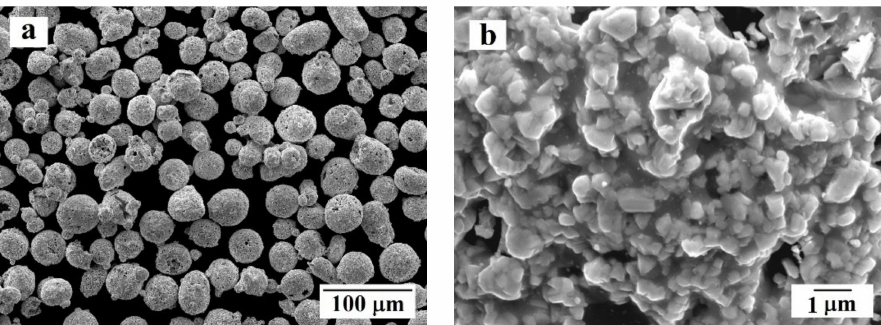
Figure 2. WC-Co-Cr powder used for detonation spray coating deposition: ( a ) overview; ( b ) surface morphology of an individual granule.